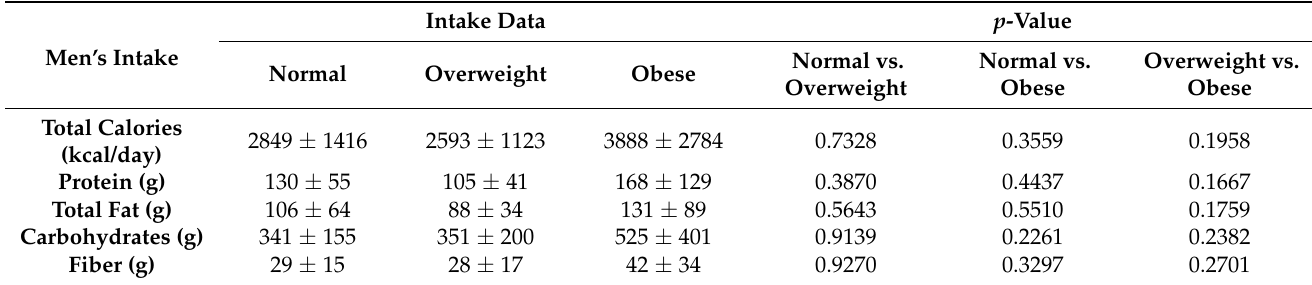
Table 2. Men’s macronutrient intake.